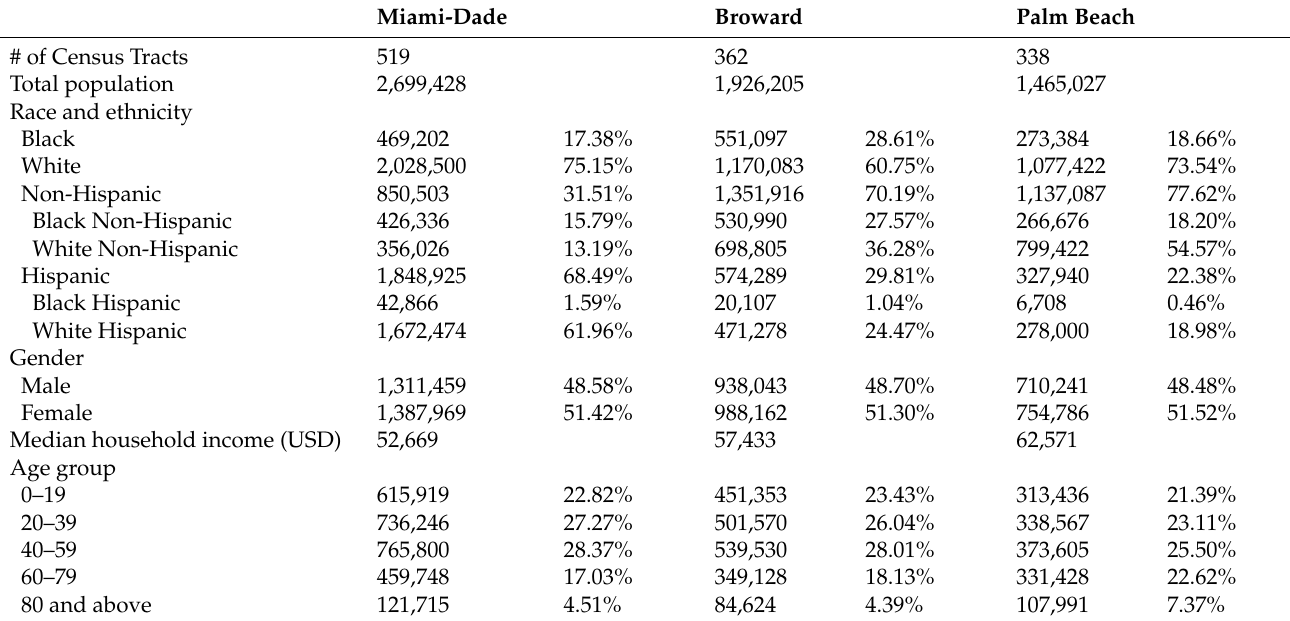
Table 1. Demographics of Miami-Dade, Broward, and Palm Beach counties.